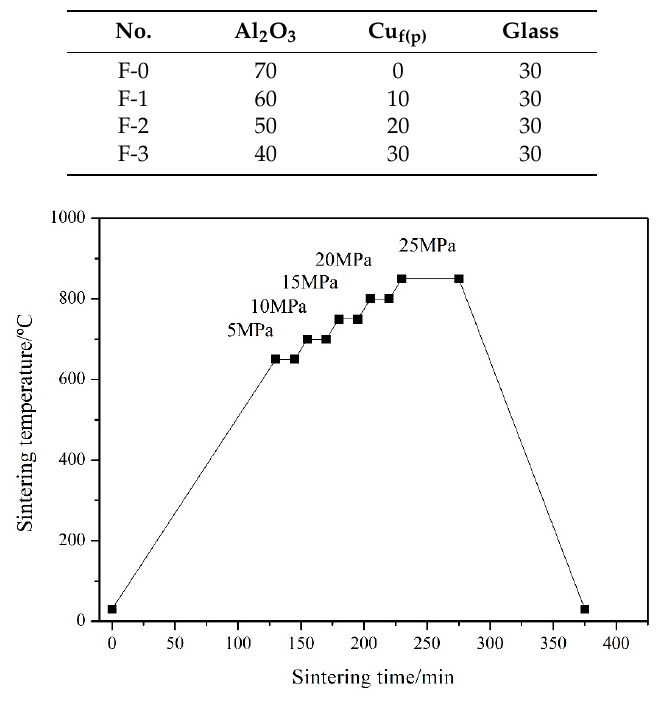
Figure 1. Schematic of the hot-pressing process.